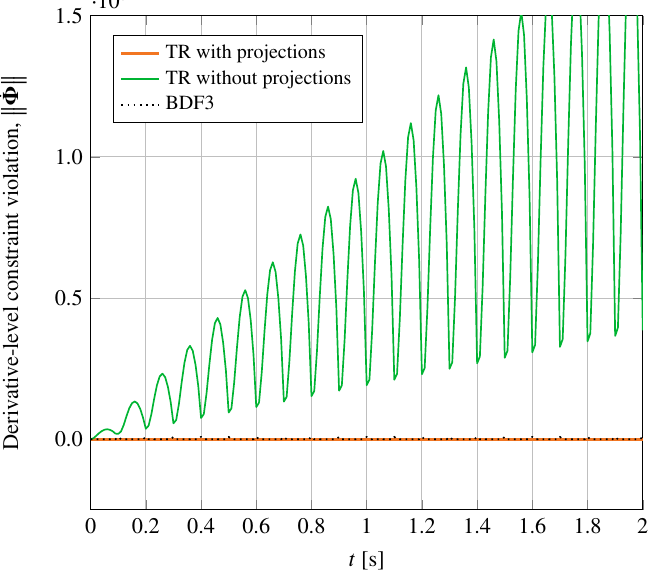
(cid:13) (cid:13) (cid:13) ˙ Φ (cid:13)